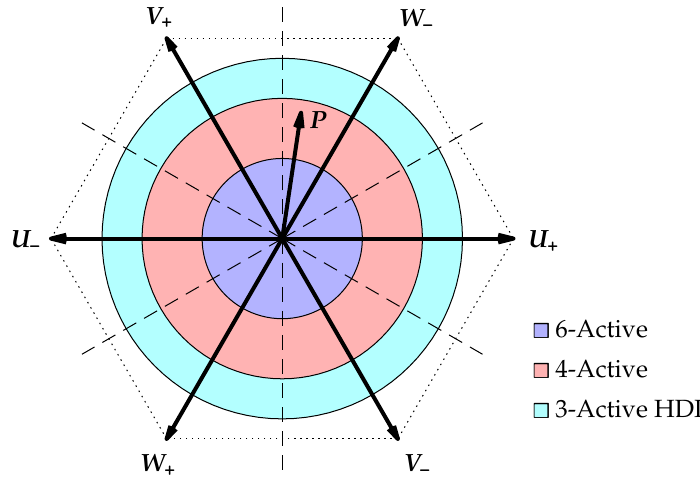
Figure 12. Combination of different SVMs during operation for achieving a high modulation area and a maximum performance of the self-sensing position measurement ( t INF =